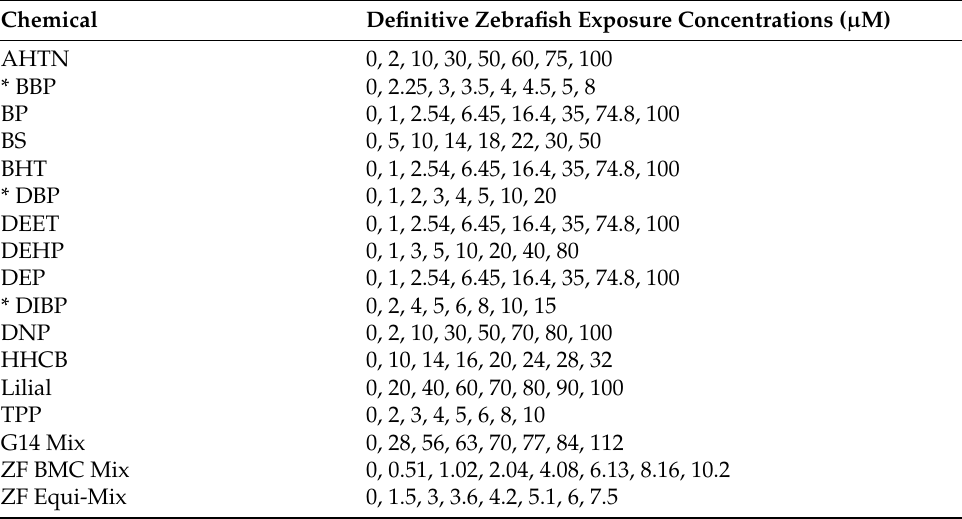
Table 4. Definitive nominal water concentrations used for early life-stage zebrafish bioactivity